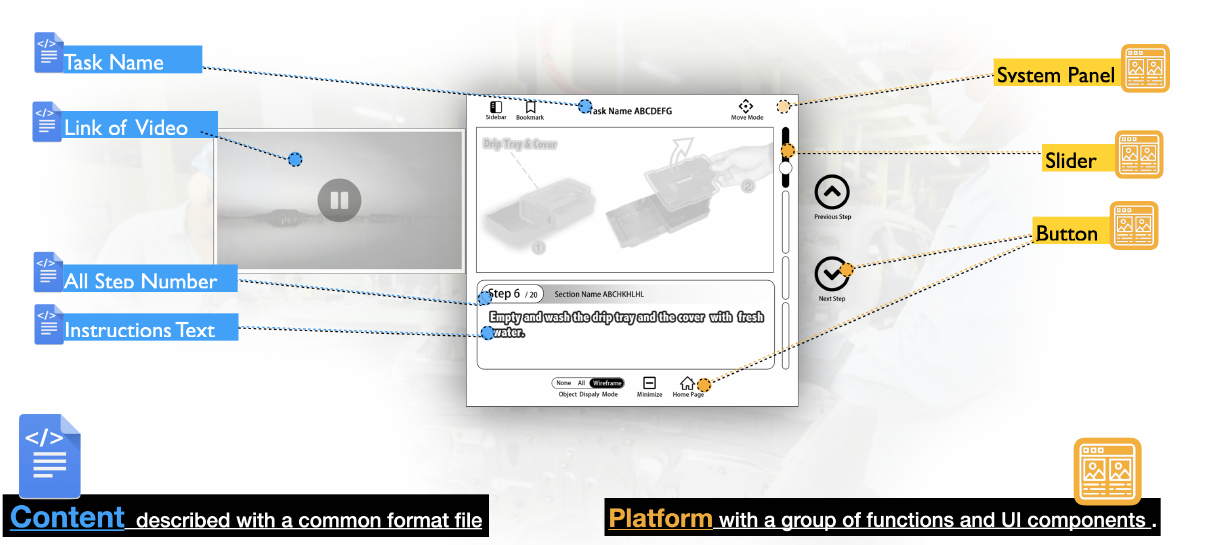
Figure 1. Conceptual diagram of platform and content in the AR task support